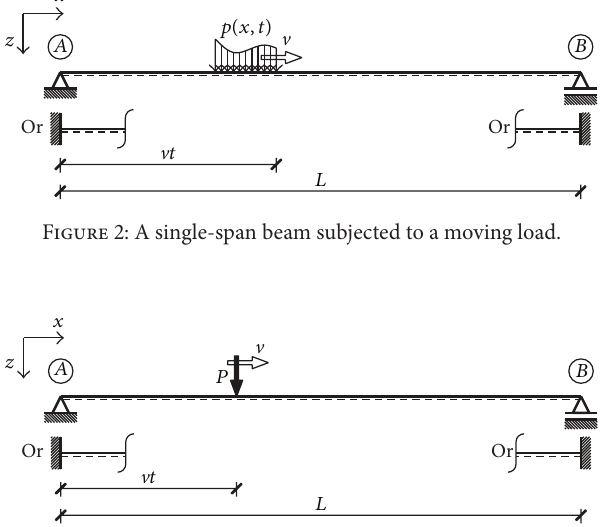
Figure 3: A single-span beam subjected to a moving point